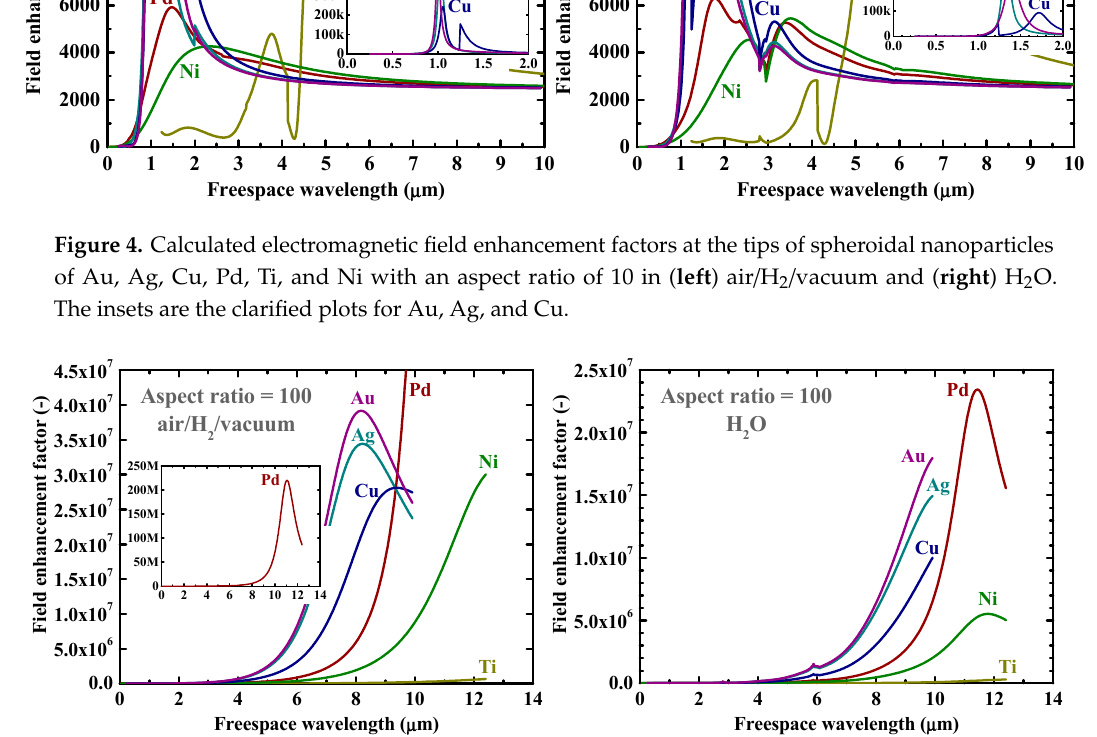
Figure 5. Calculated electromagnetic field enhancement factors at the tips of spheroidal nanoparticles of Au, Ag, Cu, Pd, Ti, and Ni with an aspect ratio of 100 in ( left ) air / H 2 / vacuum and ( right ) H 2 O. The inset of ( left ) is the clarified plot for Pd. Nanomaterials 2019 , 9 , x FOR PEER REVIEW